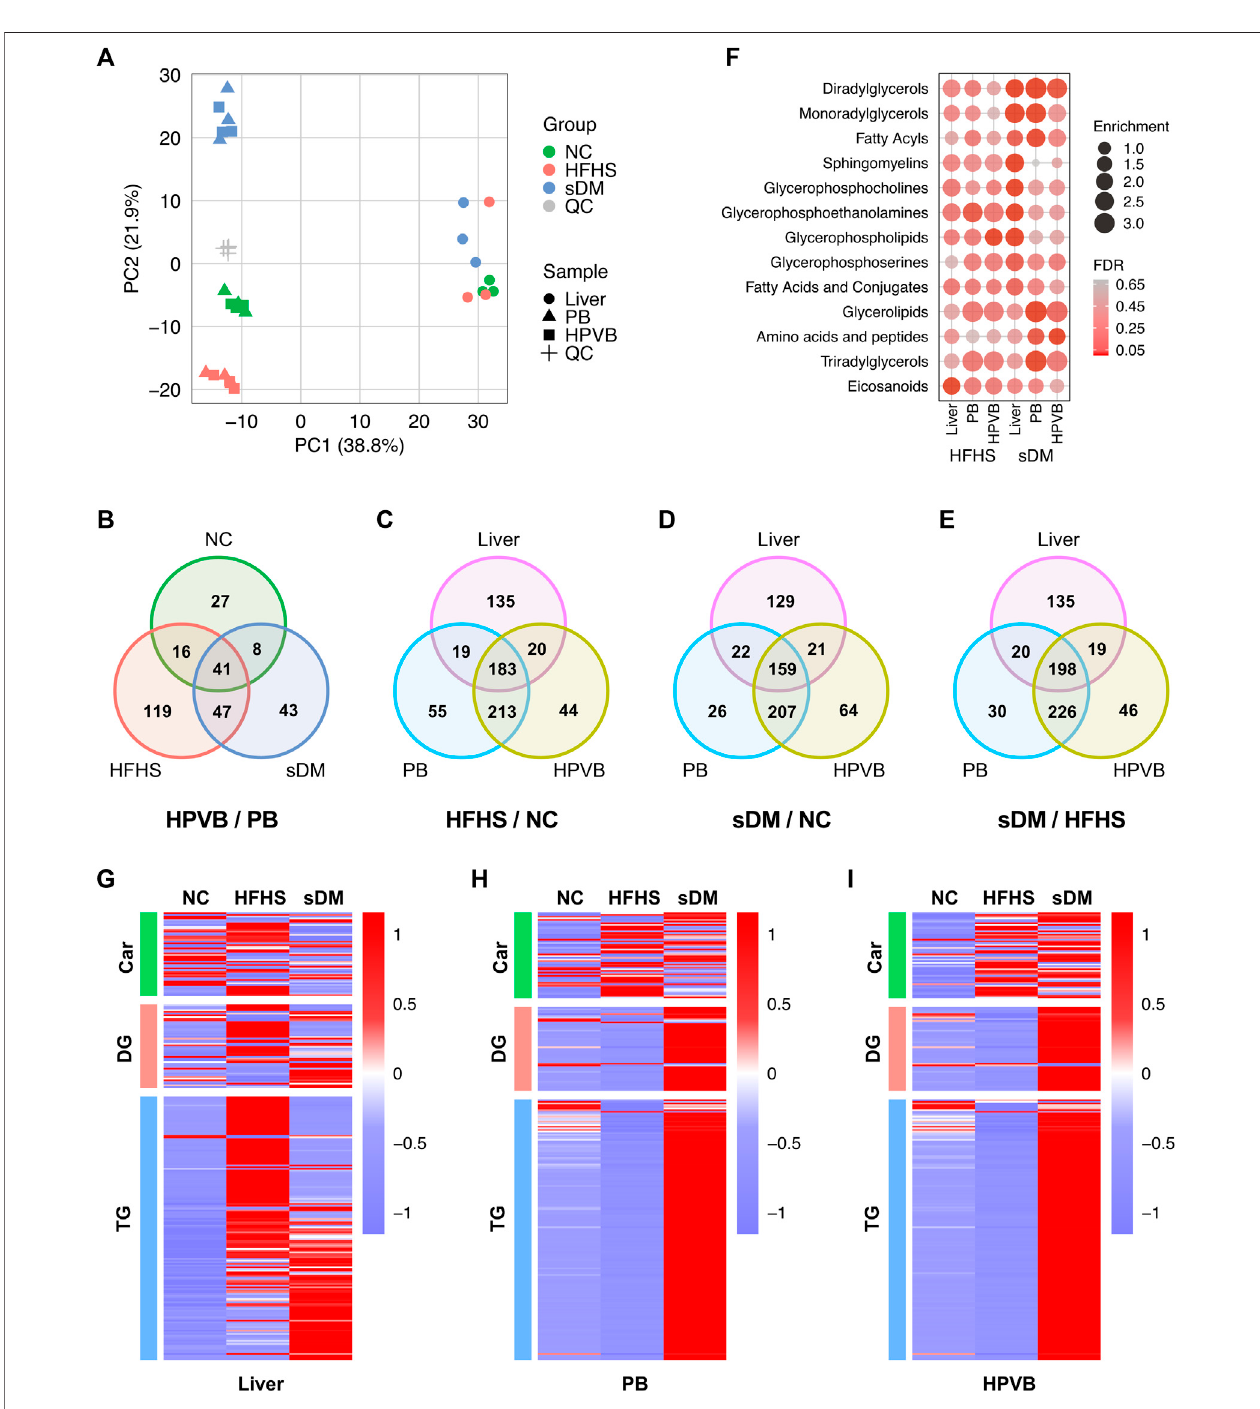
FIGURE 2 | The comparison among the metabolomics data. (A) Principal component analysis of the 1,082 metabolites identi fi ed from all 27 samples and 4 QC samples. (B) The metabolites of signi fi cantly different levels between the PB and HPVB samples of each group. (C – E) The metabolites of signi fi cantly different levels between the HFHS and NC groups (C) , the sDM and NC groups (D) , and the sDM and HFHS groups (E) . (F) The enriched classes of molecules found from the metabolites altered in the HFHS and sDM groups. (G – I) The inter-group changes of acylcarnitines (Car), diacylglycerols (DG), and triacylglycerols (TG) in the liver (G) , PB (H) , and HPVB (I) samples.